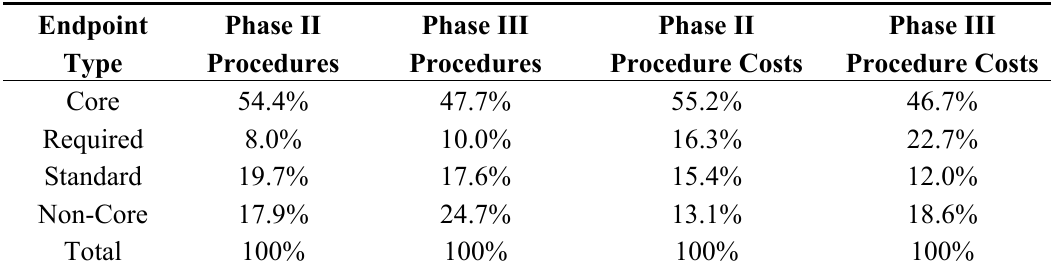
Table 2. Distribution of Procedures and Direct Costs per Procedure by End Point